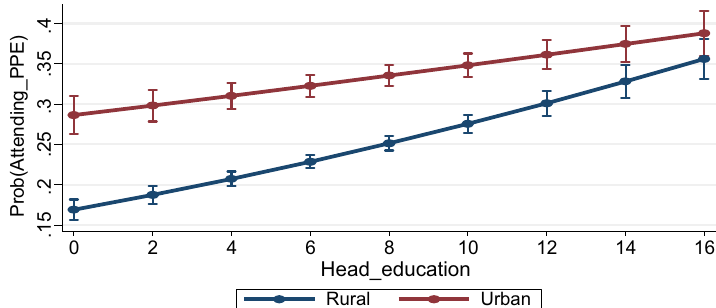
Fig. 2 Predicted probabilities of attending pre-primary education by location and household head’s education status